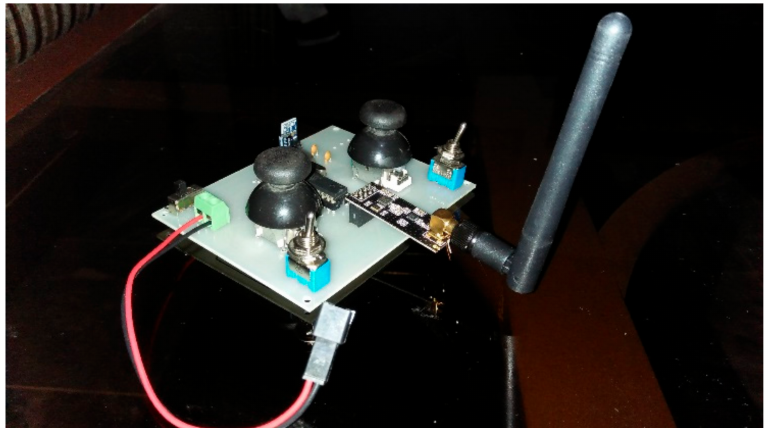
Figure 18. Hardware Assembly of Radio